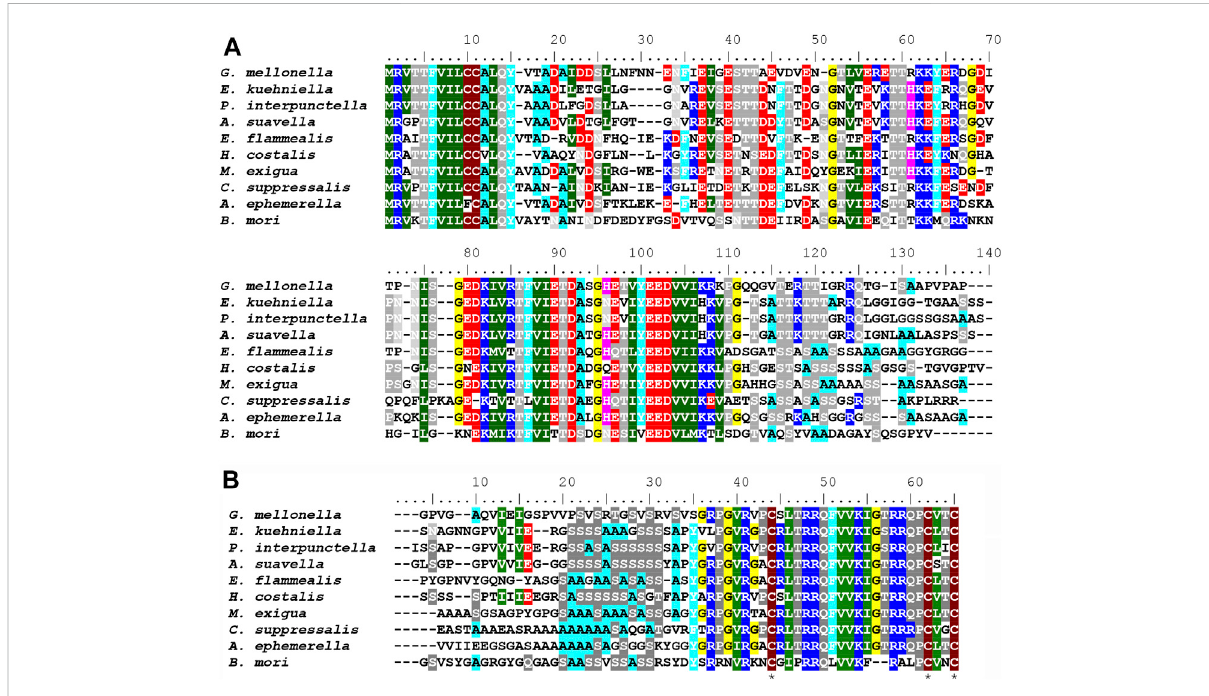
FIGURE 7 (A) Multiple sequence alignment of FibH N-terminal sequences (B) Multiple sequence alignment of FibH C-terminal sequences Conserved cysteine residues are marked with asterisks. Genbank accession numbers are listed in Table 3. Complete amino acid FibH sequences are shown in Supplementary Figure